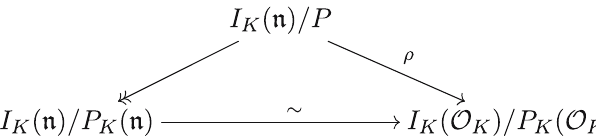
Figure 1: A commutative diagram of ideal class